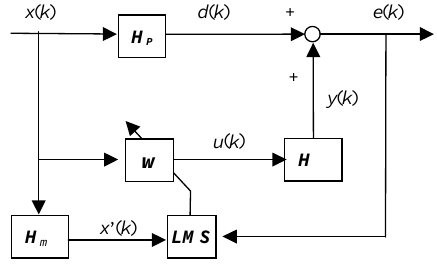
Fig. 1. Block diagram of an ANC system using FXLMS